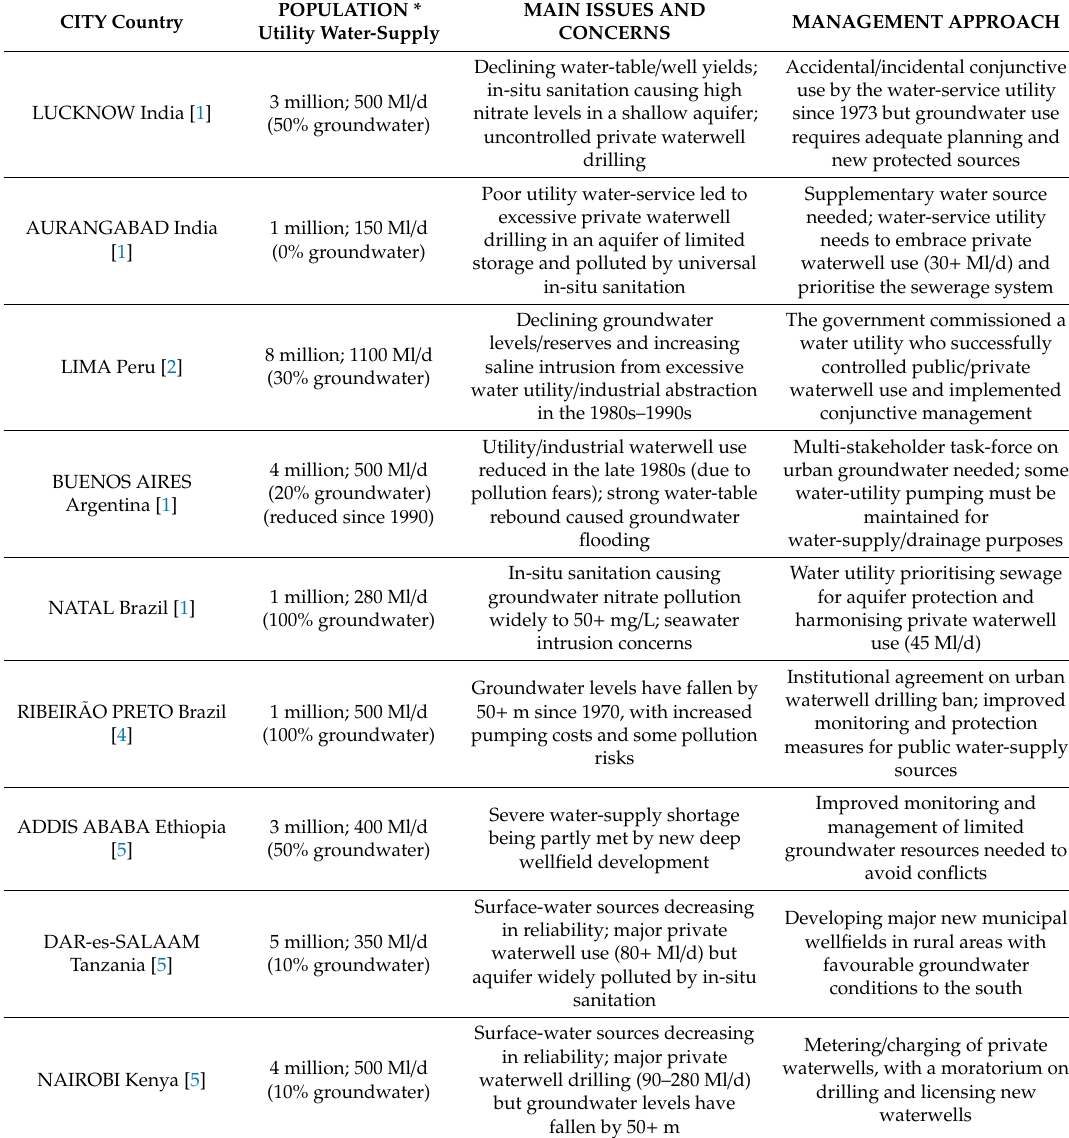
* approximate figure for water-service area (political boundaries render census data